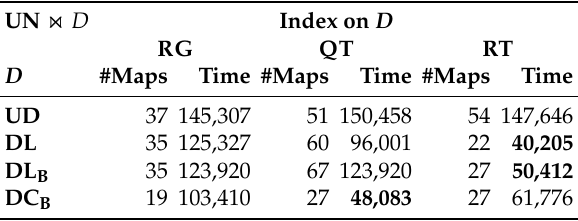
Table 6. Result of experiments with joins on synthetic datasets. The UN has been indexed with a regular grid, while D is partitioned with various kind of index. The reported time is in milliseconds and is the average of the times of about 10 queries for each kind of dataset distribution for D .